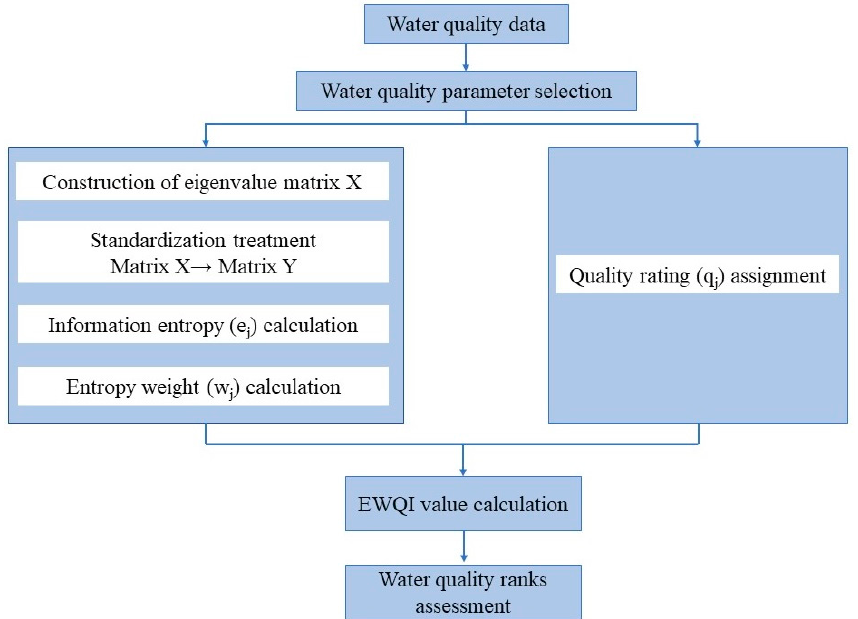
Figure 2. The overall flow framework of the Entropy-Weighted Water Quality Index (EWQI). (1) The first main step of the EWQI assessment is to obtain the entropy weight of each hydrochemical parameter for all